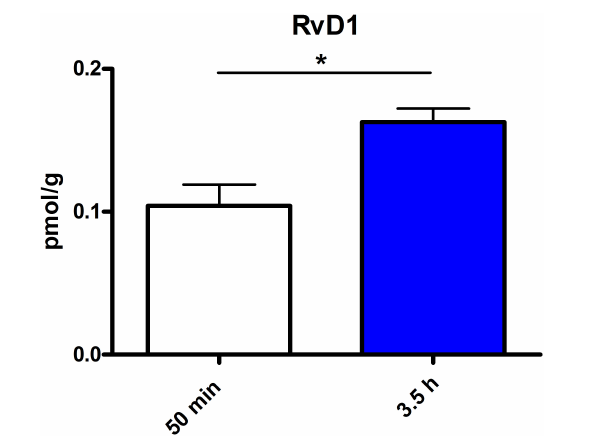
FIGURE 6 | RvD1 concentration in spleen after different time points of PEA treatment: absolute concentrations of RvD1 [normalized to the tissue weight (spleen ˆ= 20 mg)] after two time points of PEA treatment presented as mean value ± SEM. RvD1 is significantly increased after 3.5 h of PEA treatment as compared to 50 min. Of note, RvD1 was not detected in saline-treated control mice, likely because they are at basal level under limit of detection/ quantification or not biosynthesized. Data were considered significant at a p -value < 0.05, e.g., ∗∗∗ p < 0.001, ∗∗ p = 0.001 to 0.01; ∗ p = 0.01 to 0.05.